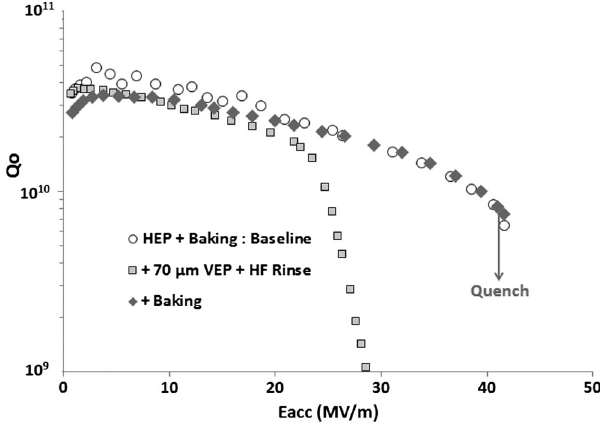
FIG. 3. Radio-frequency results of the “ 1DE1 ” cavity at 1.6 – 1.7 K before/after VEP at 6 V. The baking process has been performed at 137 ° C during 60 h.